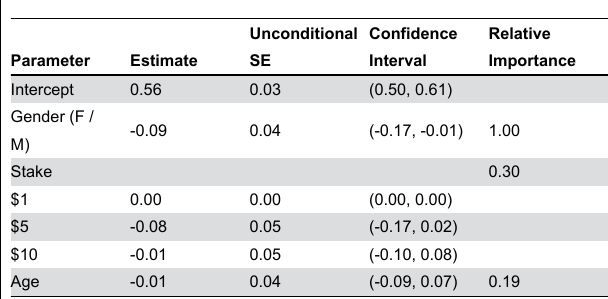
4. Estimates, unconditional standard errors, confidence intervals and relative importance for parameters included in the top models for players from